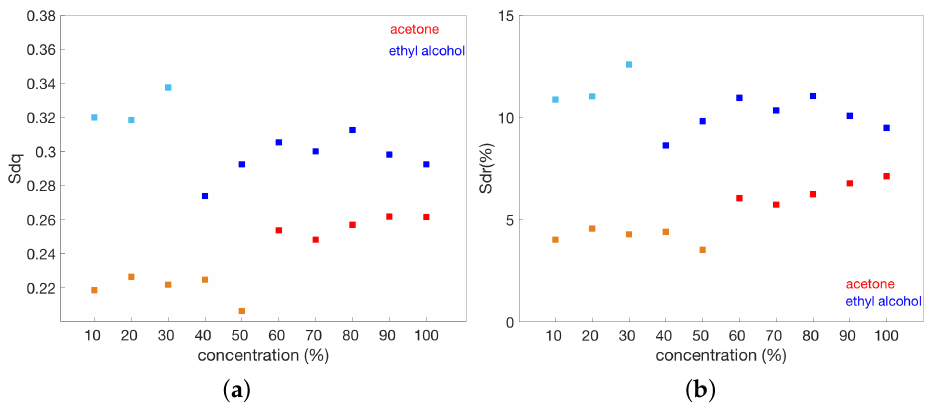
Figure 10. Variation in the hybrid parameters with solvent concentration: ( a ) RMS gradient Sdq . ( b ) Developed interfacial area ratio Sdr . Lighter colors represent the solvent concentrations before they become effective (based on UV